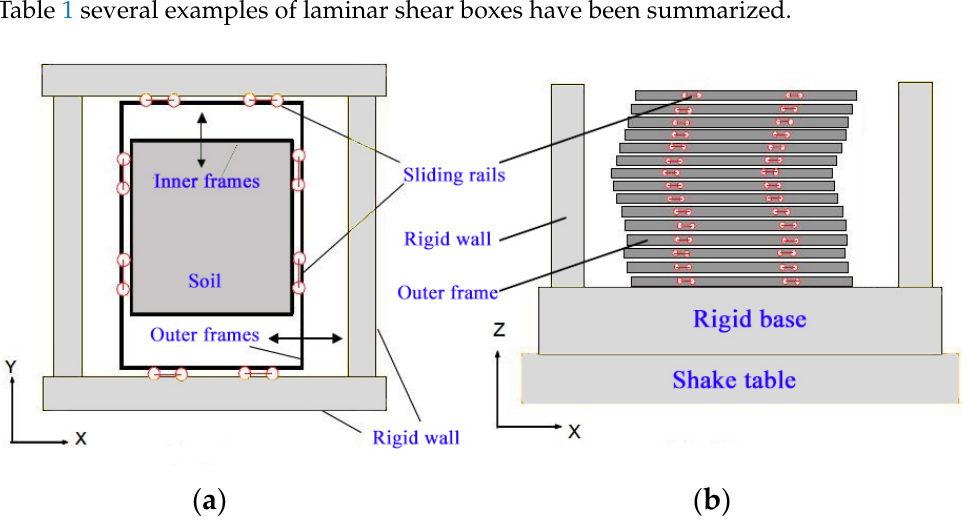
Figure 13. General view of the laminar container (From Jafarzadeh [30]; modified). A 2D laminar shear box was designed by Ueng et al. [38] at the National Centre for Research on Earthquake Engineering (NCREE) in Taiwan for the study of liquefaction and soil-structure interaction. To allow biaxial motion and to ensure non-torsional motion, a special mechanism design was adopted.